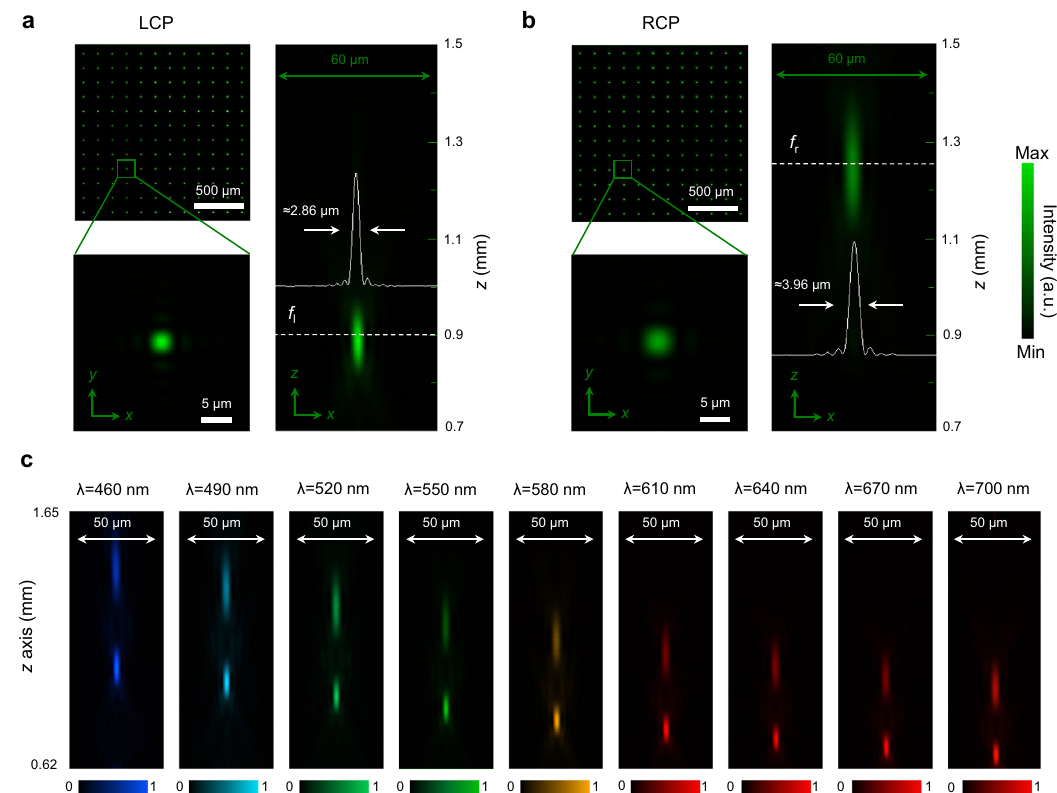
Fig. 2 Measured intensity distributions of photonic spin-multiplexed metalens arrays. Focal spots in the x - y and x - z plane for ( a ) LCP and ( b ) RCP incident light at the wavelength of 530 nm. For ease-of-viewing, here we show an array of 12 × 12 focal spots (top left). The solid white lines show the horizontal cuts of the intensity distributions of focal spots. c Dispersion of a single submetalens illustrated by metalens focusing at different focal lengths for the wavelength spanning from 460 nm to 700 nm. The incident light is linearly